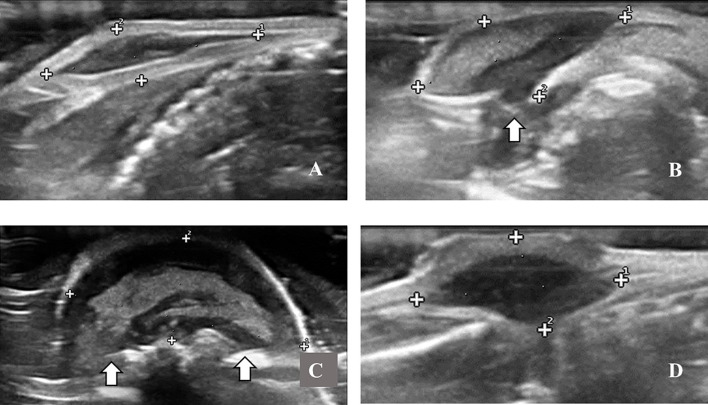
B-mode ultrasound images of Ehrlich Solid Carcinoma induced in the subcutaneous tissue of Swiss albino mice; showing in (A) complete capsule and circumscribed margins; (B) discontinuity in the capsule (marked by arrow), giving rise to an image with partially undefined margins, (C) significant discontinuity in the capsule (marked by arrows), giving rise to an image with indistinct margins, evidencing too, the heterogeneous interior; (D) homogeneous and hipoechoic interior.